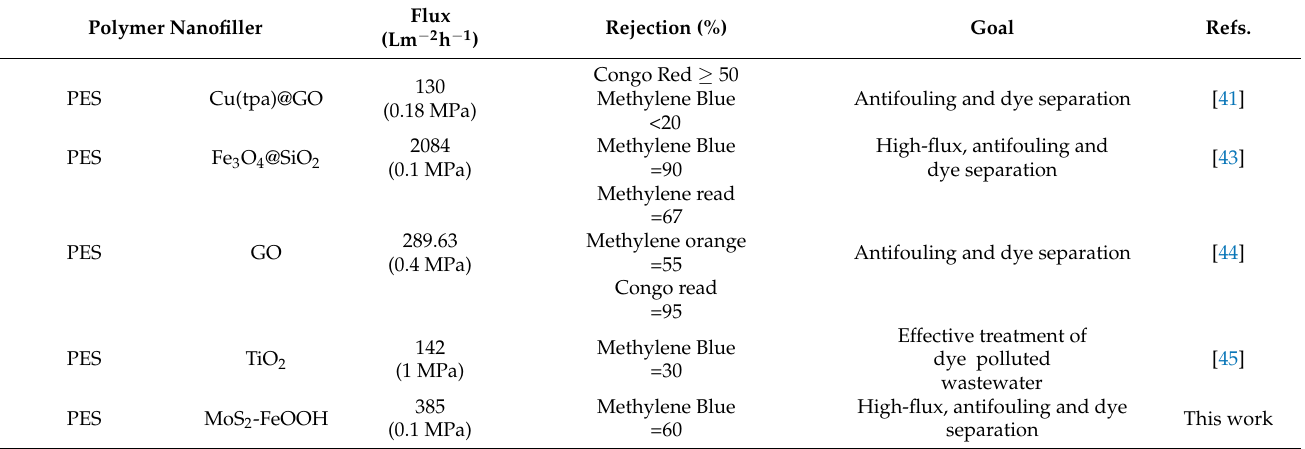
Table 3. Research done to improve composite PES membranes in dye wastewater treatment.